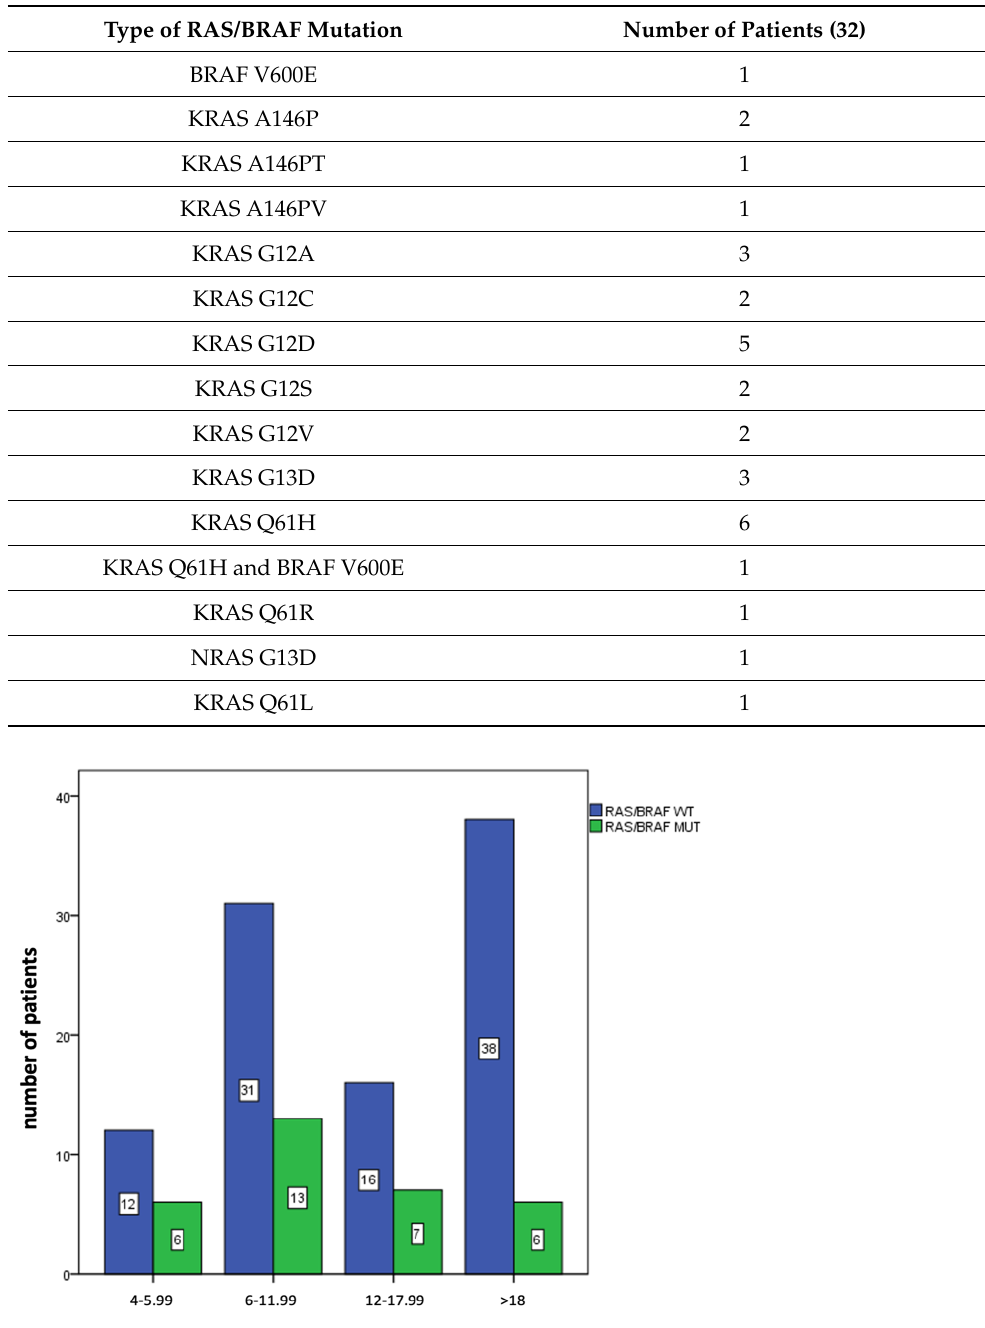
Table 2. Type of KRAS / NRAS / BRAF mutations that were observed during pretreatment plasma liquid biopsy analysis by using the Idylla TM Biocartis platform.